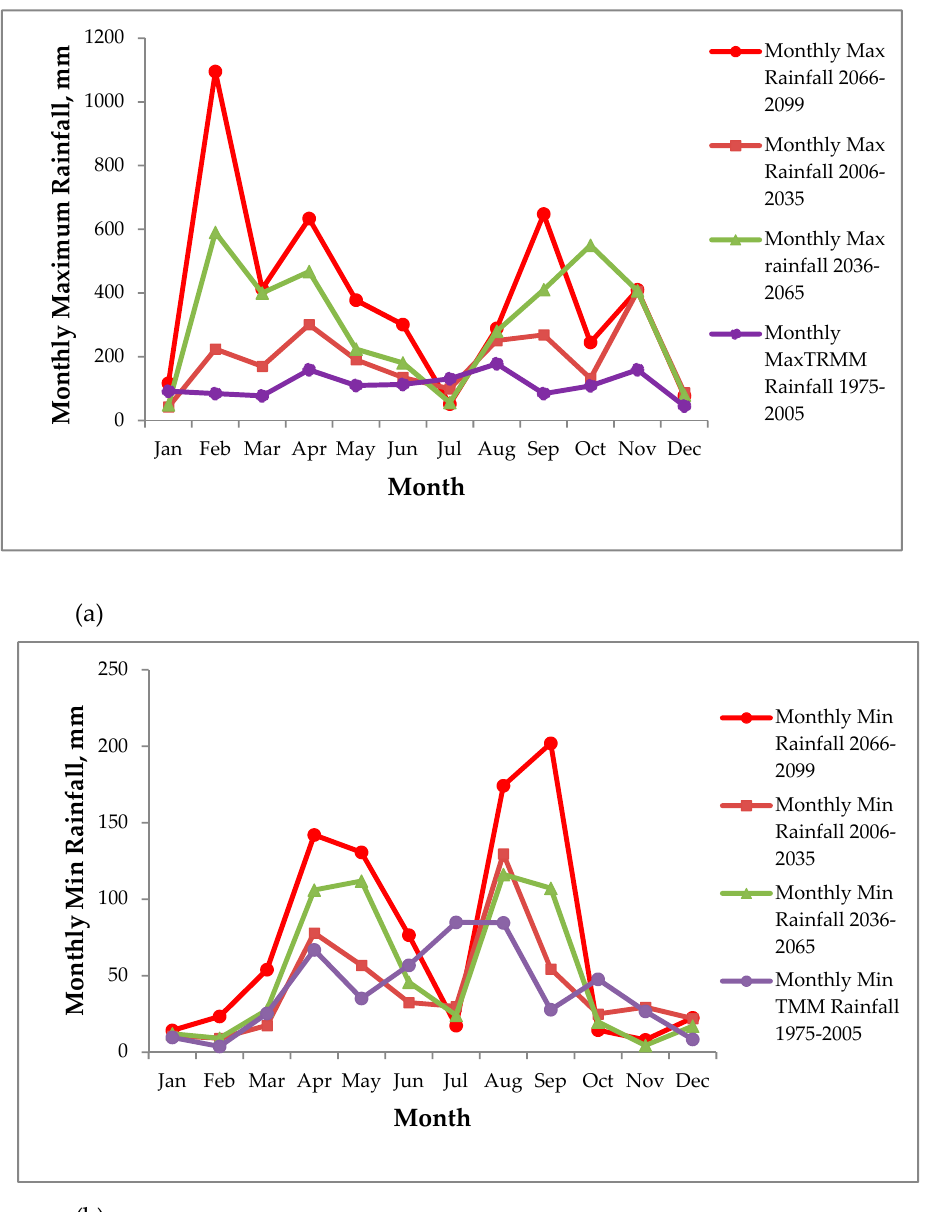
Figure 12. Agoro CanESM2 future average monthly rainfall variations for ( a ) maximum monthly rainfall and ( b ) minimum monthly rainfall.